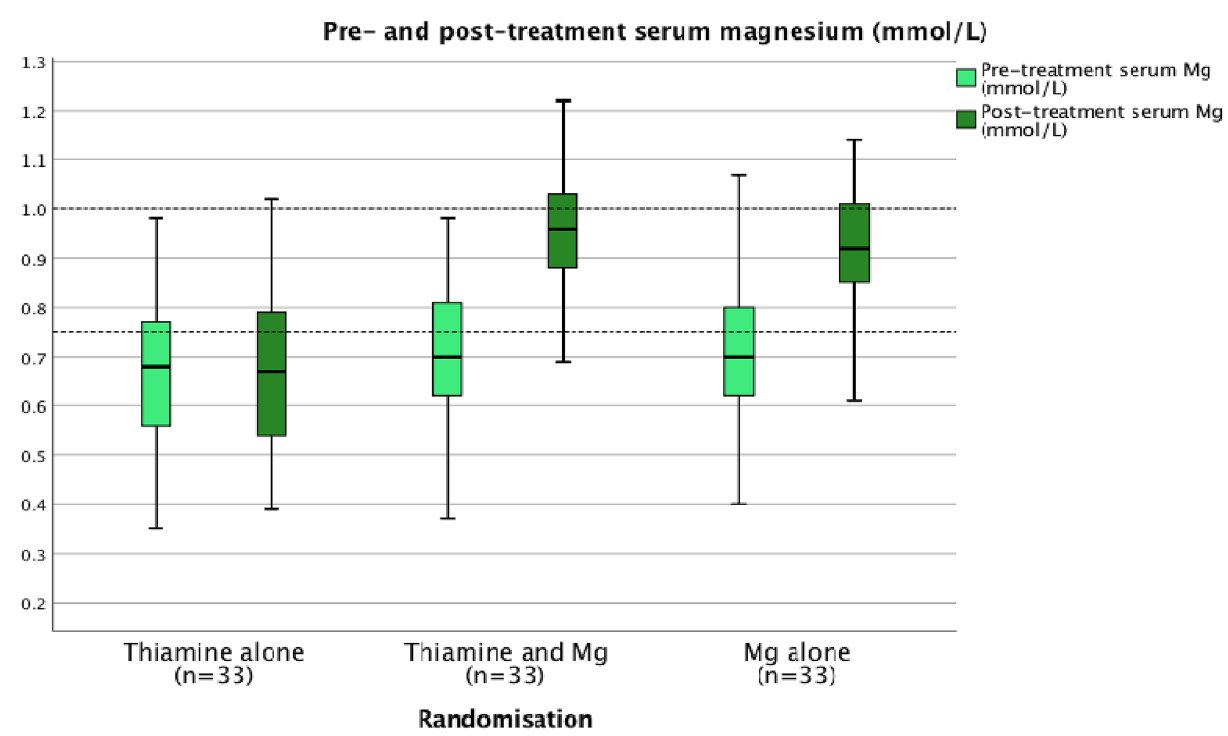
Figure 3. Pre- and post-treatment serum magnesium concentrations according to